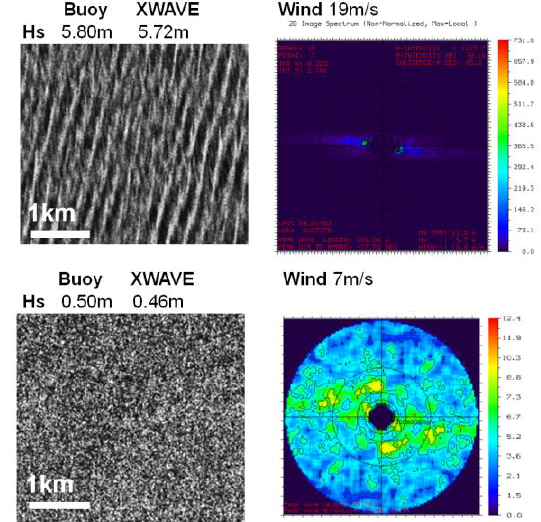
Figure 4. Two examples of different sea state at the same position buoy “Elbe”. TerraSAR-X storm acquisition on 09.12.2011 at 05:52: long waves are well pronounced. Low wind condition on 07.01.2015 at 17:19: wave-like strictures are hardly visible, nevertheless, H S can be accurately estimated based on noise properties of spectra and wind